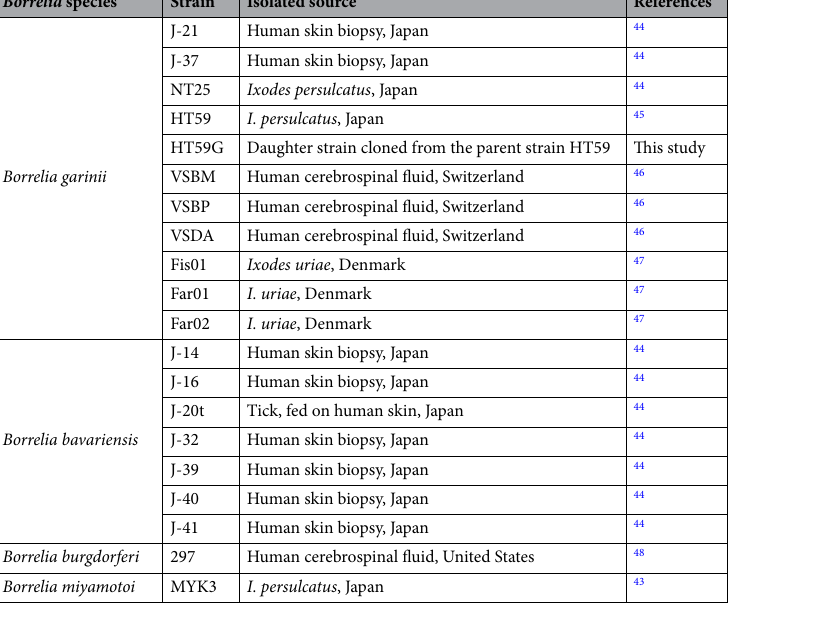
Table 2. Borrelia strains used in this